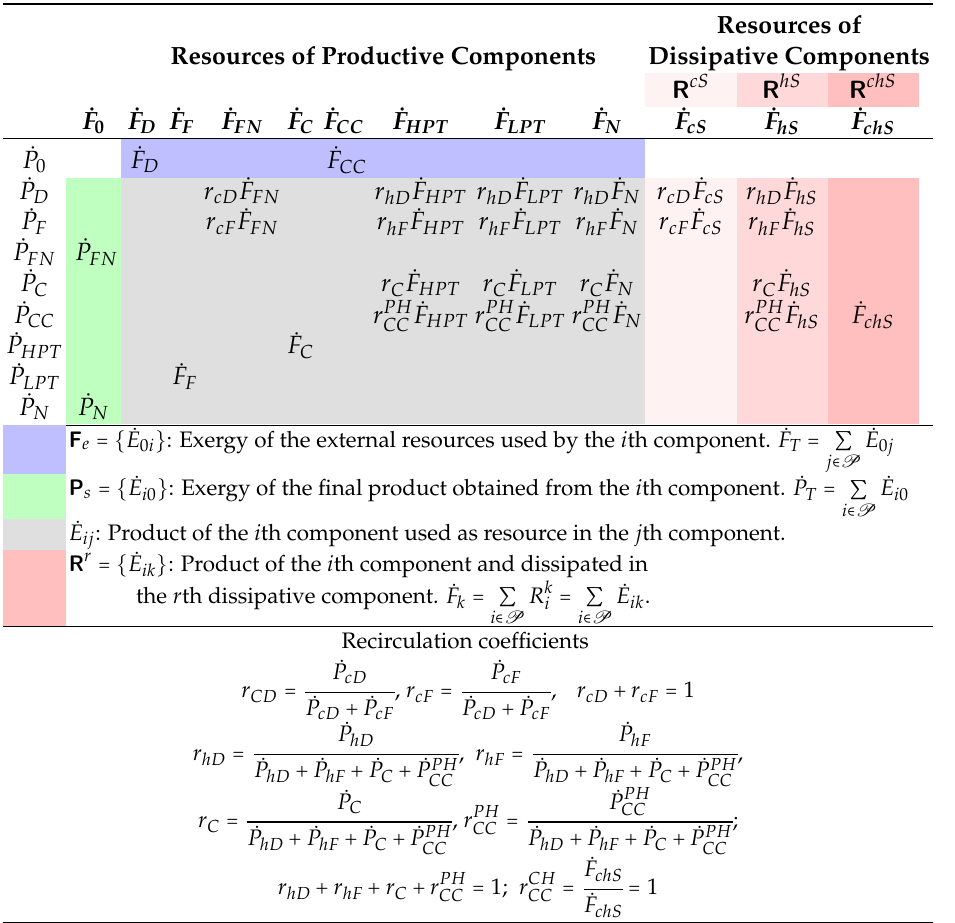
Table 4. FPR table and recirculation coefficients for the